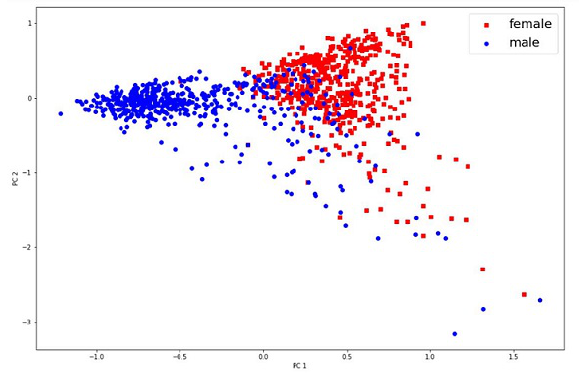
Figure 6. 2-dimensional PCA scatter plot for